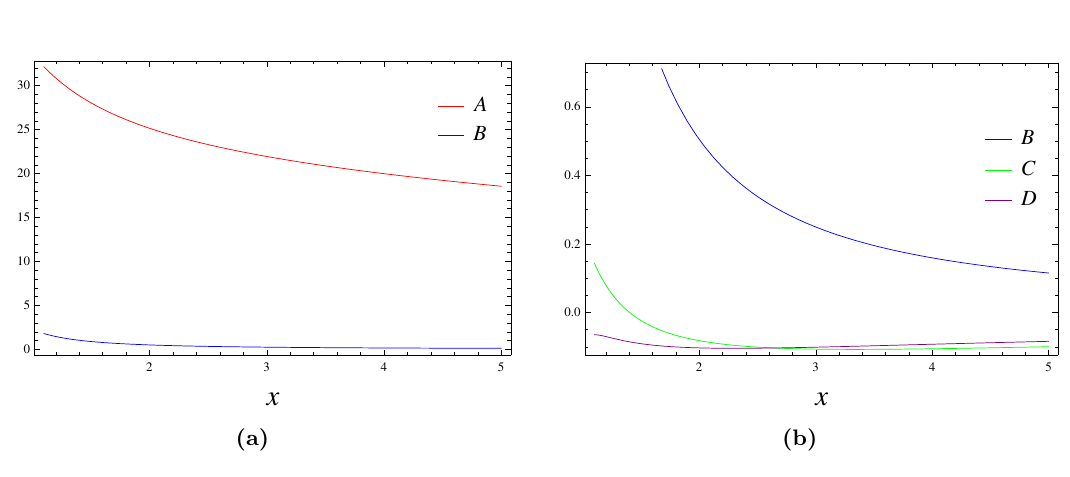
Table 1. Values of A i , B i , C i and D i defined in eq. (3.1) when the two messenger masses are equal. Symmetric parts are not displayed. ζ n denotes the Riemann’s zeta function.